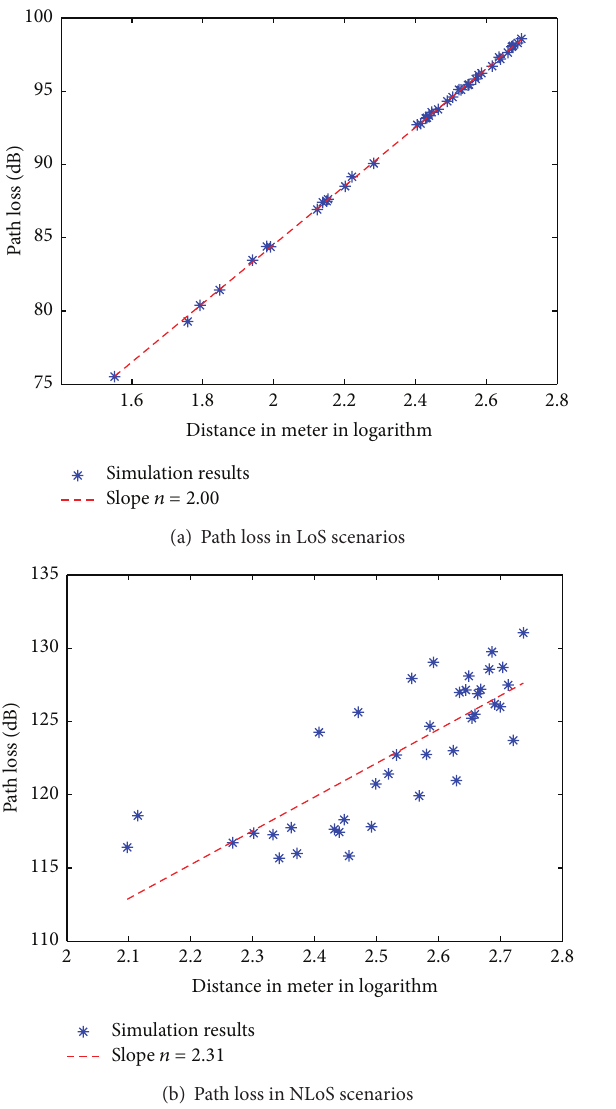
Figure 5: Path loss models extracted for the simulation results obtained in LoS and NLoS scenarios.